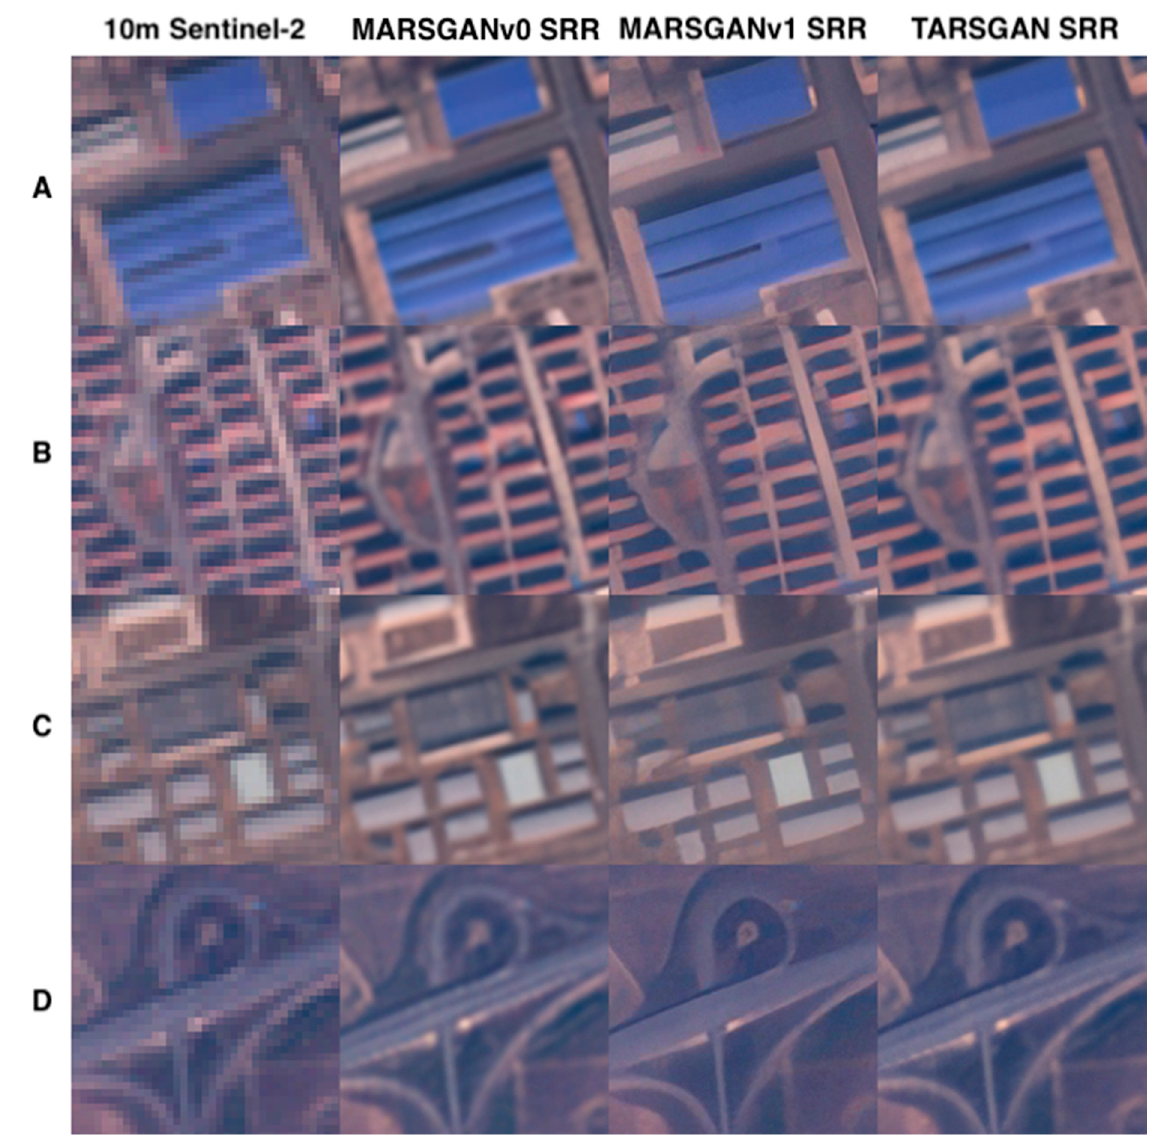
Figure 17. ( A – D ) Cropped examples of Site-1 of the original 10 m/pixel Sentinel-2 image, the MARSGAN SRR as described in [27] (MARSGANv0), MARSGAN SRR trained with upsampled and blurred LR using perceptual loss (MARSGANv1), and the MARSGAN SRR trained with upsampled and blurred LR using the SSIM loss (TARSGAN). All subfigures are self contrast stretched and have sizes of 625 m × 625 m.